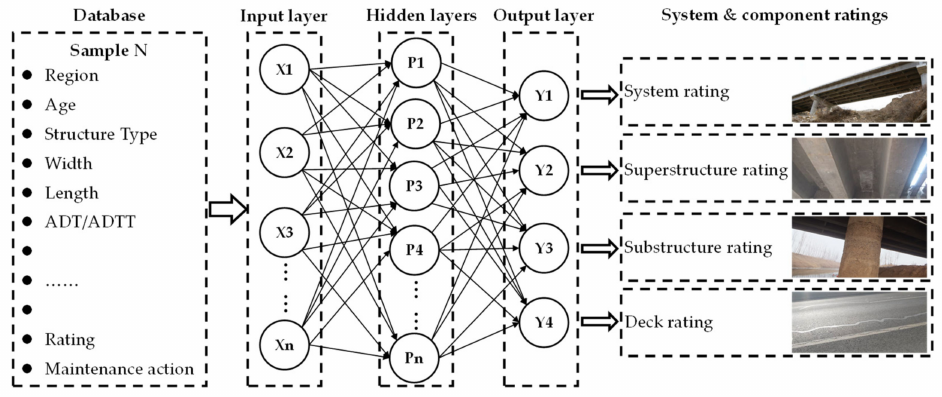
Figure 5. The topology of the neural network based on the specified features. Neural networks are composed of several neurons and links. These neurons are connected to transfer the information. Neurons receive inputs from up-layer neurons, and each neuron performs a different active function with certain weights and thresholds on the received data. Neural networks can include one input layer, one output layer, and one or more hidden layers. The input layer transforms the basic database into the neural network. The hidden layers extract the features and correlations from the input data and provide the results to the output